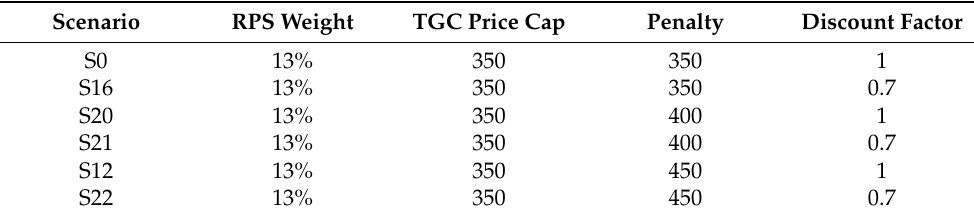
Table 7. Scenarios for analyzing impacts of discount factors under different